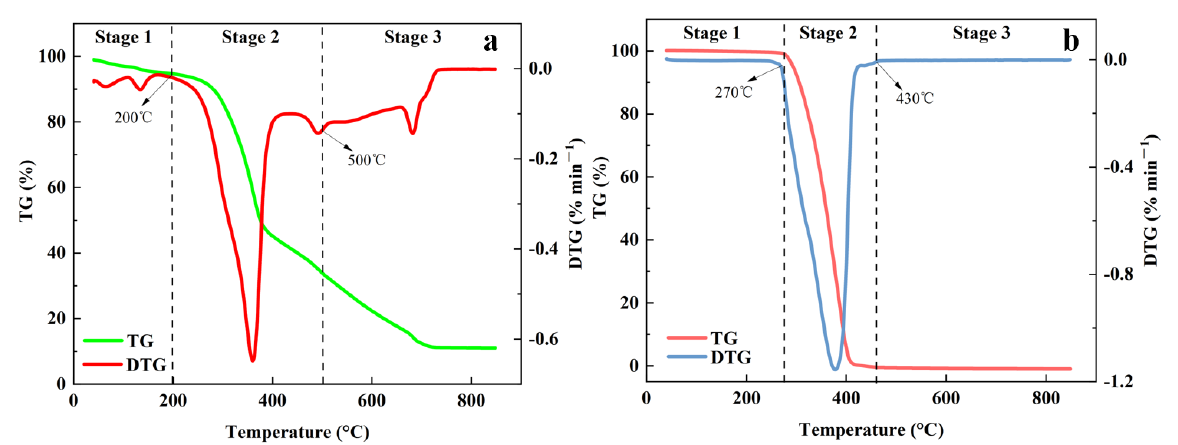
Figure 1. ( a ) TG-DTG curve of pyrolysis of MS at a heating rate of 10 °C·min -1 ; ( b ) TG-DTG curve of pyrolysis of PP at a heating rate of 10 °C·min -1 . TG: thermal weight curve, DTG: differential thermal pyrolysis of PP at a heating rate of 10 ◦ C · min − 1 . TG: thermal weight curve, DTG: differential weight curve.